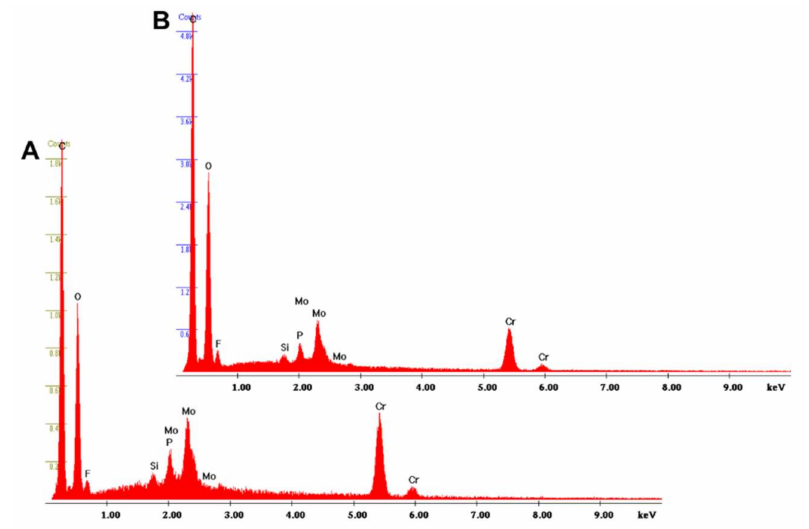
Figure 4. EDS spectra of the PMo 12 @MOF composite material (left) before and (right) after catalytic use.